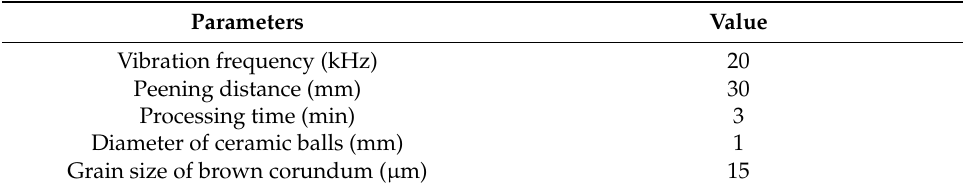
Table 2. Working parameters of ultrasonic processing.